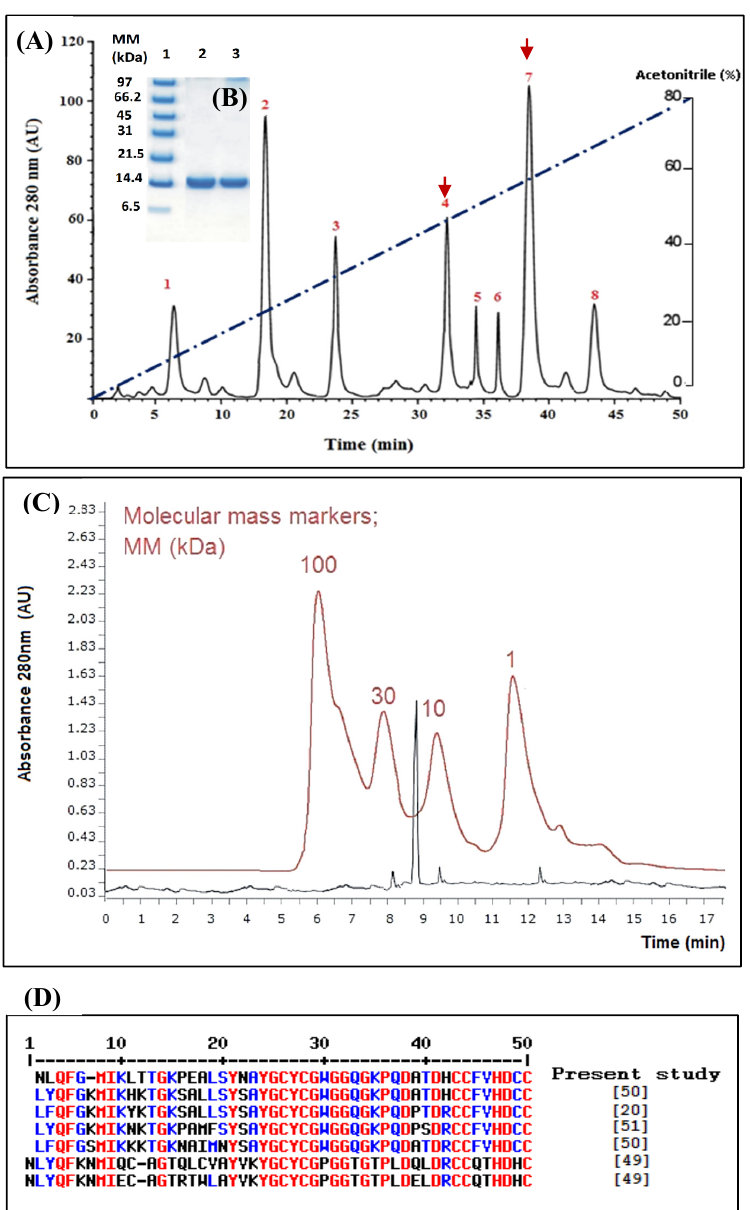
Figure 1. Chromatography on RP-HPLC using a C18 column ( A ) and SDS-PAGE (15%) ( B ) of the purified Wa PLA 2 -II. Lane 1, molecular mass markers (Enolase 100kDa, Carbonic anhydrase 30 Kda, Cytochrome C ~ 10 kDa, and Angiotensin 1kDa), lanes 2 and 3, 20 μ g of purified Wa PLA 2 -II eluted from the RP-HPLC column under reducing conditions. AU: arbitrary units. The arrows designate peaks showing the highest phospholipase A2 (PLA2) and antibacterial activities. The blue line indicates the linear acetonitrile gradient ( C ) filtration of Wa PLA 2 -II (peak 4) on the Bio-sil SEC-125 (300 mm × 7.8 mm) high performance liquid chromatography (HPLC) column. The column was equilibrated in 0.1 M phosphate buffer, pH 7, containing 0.15 M NaCl, and elution was achieved using the same buffer at a flow rate of 1 mL/min for 20 min and at room temperature. The eluate was monitored at 280 nm. AU: arbitrary units. Elution profiles of WaPLA2-II and molecular mass markers are shown in black and red, respectively. ( D ) N-terminal sequence alignment of Wa PLA 2 -II from W. aegyptia with sPLA2 G II and G I from various snake venoms ( Cerastes cerastes , Echis carinatus , Vipera renardi , Atheris nitschei , and Bungarus fasciatus). Red, blue, and black denote identical, similar, and di ff erent amino acids,